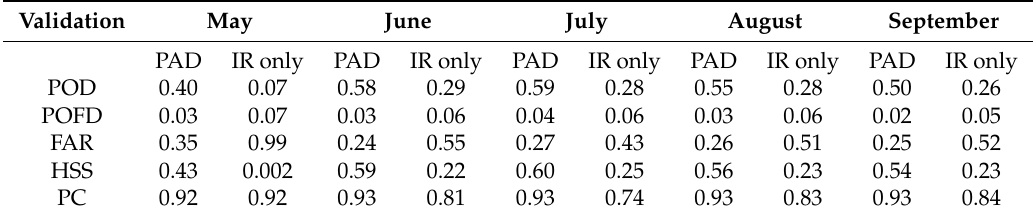
Table 7. Comparison of the new precipitation area delineation (PAD) and IMERG’s IR only precipitation